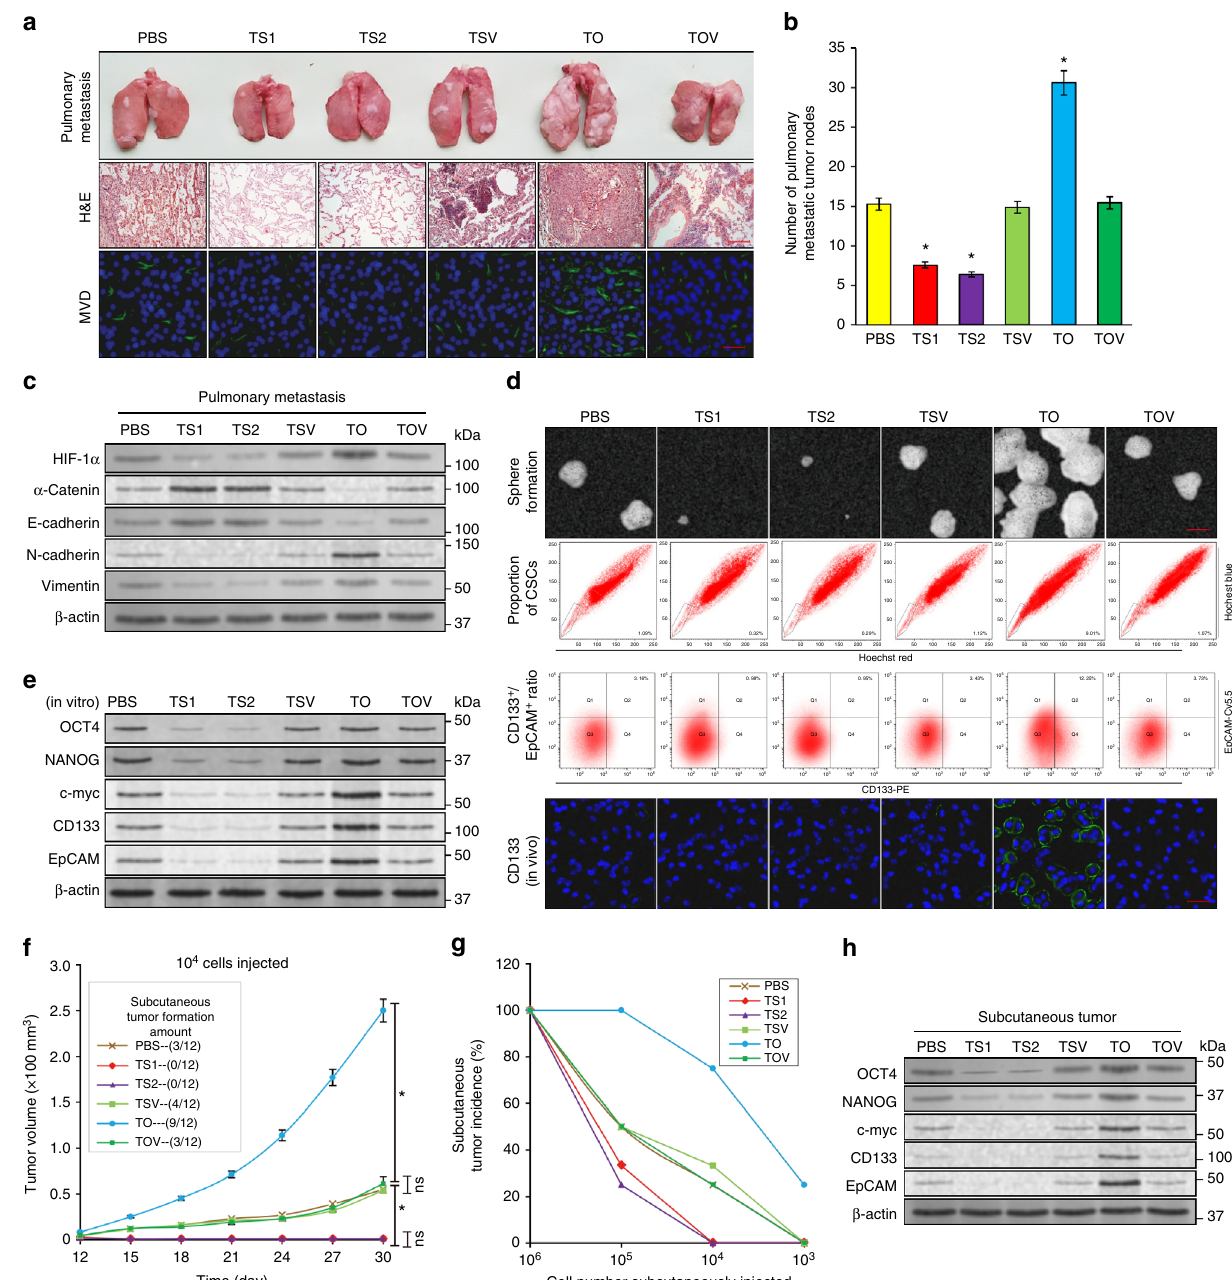
Fig. 6 In vivo effects of nanomedicines on metastasis and stemness activities. a Pulmonary metastasis ( fi rst panel, top down) and H&E staining (second panel, top down; Scale bar, 200 μ m) of the metastatic tumor after 20 days of treatment; third panel from top down, tumor angiogenesis determined by microvessel density (MVD) assay (Scale bar, 20 μ m; Blue, DAPI-indicating nuclei; green, FITC indicating CD31 protein). b Pulmonary metastatic tumor nodes counted after 20 days of treatment. c Protein expression levels of angiogenesis marker HIF-1 α , epithelial markers α -Catenin and E-cadherin and mesenchymal markers N-cadherin and Vimentin in pulmonary metastasis tumor tissues. d First panel from top down, cell stemness measured by sphere formation assay (Scale bar, 100 μ m); second panel from top down, proportions of cancer stem cells (CSCs) measured by Hoechst 33342 dye exclusion assay; third panel from top down, fl ow cytometry analyses of the percentage of CD133 + / EpCAM + cells in Hep3B cell populations; 4th panel from top down, in vivo CD133 + cancer stem cell propotion displayed by immuno fl uorescence staining (Scale bar, 20 μ m; Blue, DAPI-indicating nuclei; green, FITC indicating CD133 protien location). e In vitro protein expression levels of general stem cell markers (OCT4, NANOG, c-myc) and cancer stem cell surface markers (CD133, EpCAM) determined by western blotting assay. f Effect of nanomedicine treatments on tumor incidence rates and growth speeds in subcutaneous tumor model established via subcutaneous injection of 1 × 10 4 Hep3B cells. g Oncogenic potential determined by limiting dilution assay to measure tumor incidence; various amounts of Hep3B cells (1 × 10 3 , 1 × 10 4 , 1 × 10 5 or 1 × 10 6 ) were injected subcutaneously before nanomedicine treatment (see also Supplementary Fig. 7). h Protein expression levels of stem cell markers and cancer stem cell surface markers in subcutaneous tumor tissues. Data were represented as means ± S.D. Error bars represent the S.D. values ( n = 12; * P < 0.05; ns, not signi fi cant. Signi fi cant differences were analyzed by two- way ANOVA with multiple comparisons for ( f ); Student ’ s t test for ( b ) and ( f ), compared with PBS control